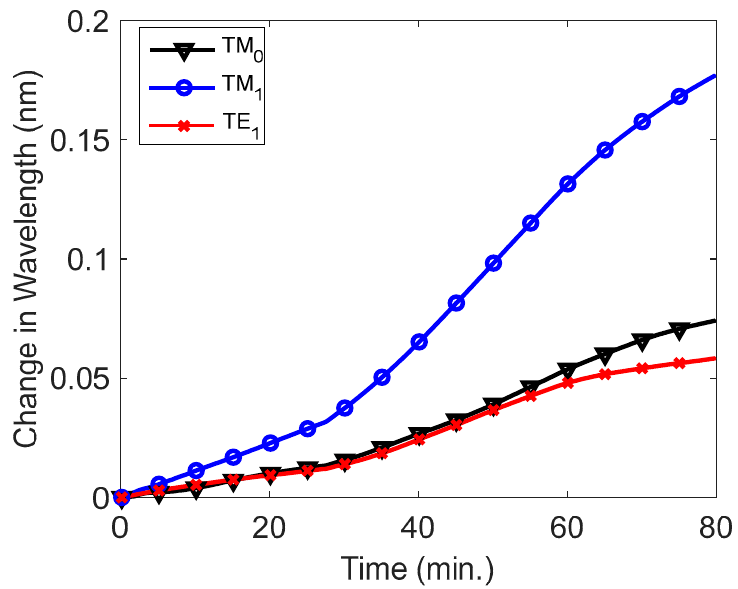
Figure 8. Experimentally measured resonance wavelength shifts during sensor incubation in a Con A and PBS solution (1 mg/mL). The TM 0 , TM 1 , and TE 1 modes are labeled in the legend as black, blue, and red, respectively.